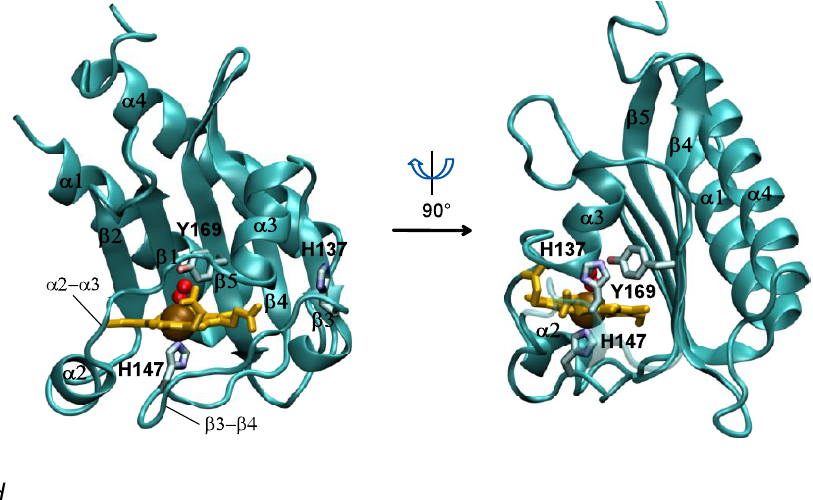
Figure 3. Crystal structure of the ferrous dioxygen complex of the DosT GAF-A domain. Reprinted with permission from [32].